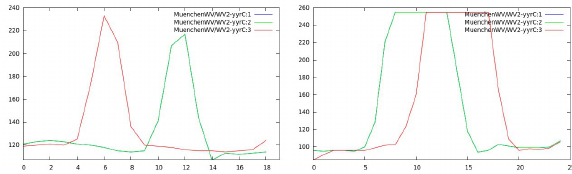
profiles of a car (left, also left green profile-line in fig. 4) and a large truck (right).